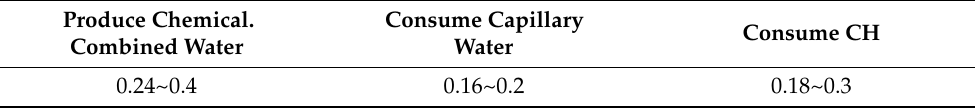
Table 1. Consumption of various substances in pozzolanic reaction per g glass powder. Produce Chemical.